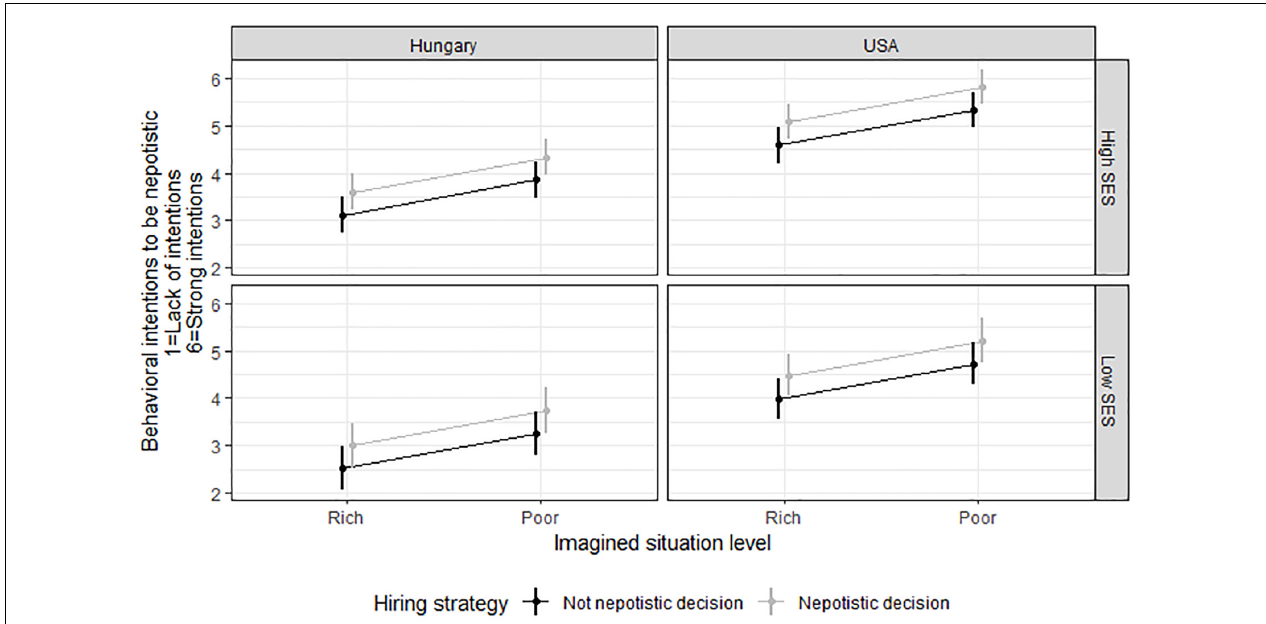
FIGURE 1 | Differences in nepotistic behavioral intentions between cultures (United States vs. Hungary), self-reported low vs. high SES, imagined poverty vs. richness, and nepotistic vs. non-nepotistic hiring strategy. For the sake of clarity, “High” and “Low” SES within each culture was based on a median split of MacArthur ladder data (Med = 6).